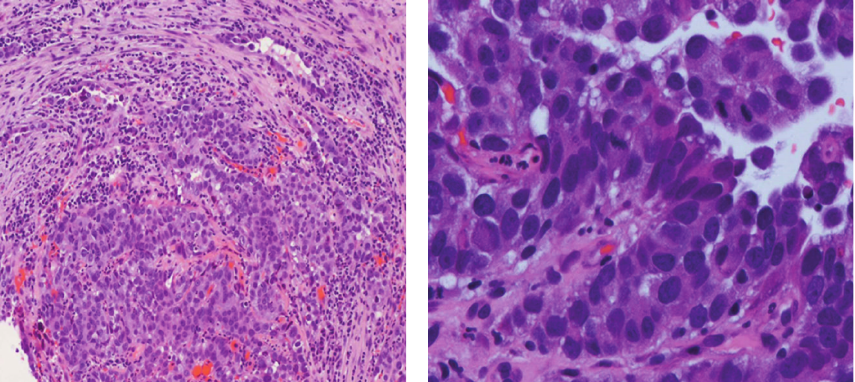
Figure 1: Cervical biopsy showing papillary serous carcinoma. The low power hematoxylin and eosin stain (4x) shows sheets of neoplastic cells embedded in fibrous tissue. The higher power hematoxylin and eosin stain (40x) shows the neoplasm having papillary architecture with hyperchromatic nuclei and marked nuclear